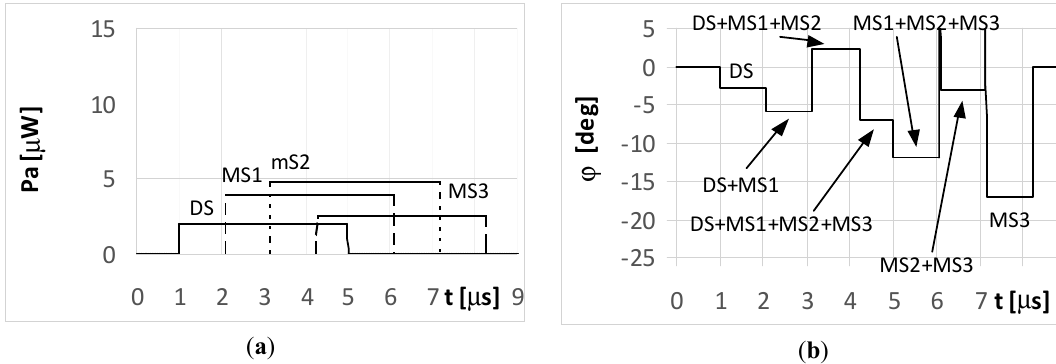
Figure 12. Envelopes of the direct signal (DS) and multipath signals (MS1, MS2, MS3) reflected from the ground, overlapping in time, and reaching UAV2 (shown in Figure 1) ( a ), and temporary angle of arrival ϕ estimated from the received resultant signal ( b ), (radar transmits simple long pulsed signal with duration t i = 4 µ s , and initial phases Φ 0D = Φ 01 = Φ 03 = 0, Φ 02 = 180 ◦ ; AOA was estimated using the monopulse phase method from the DF device installed on UAV2 ).